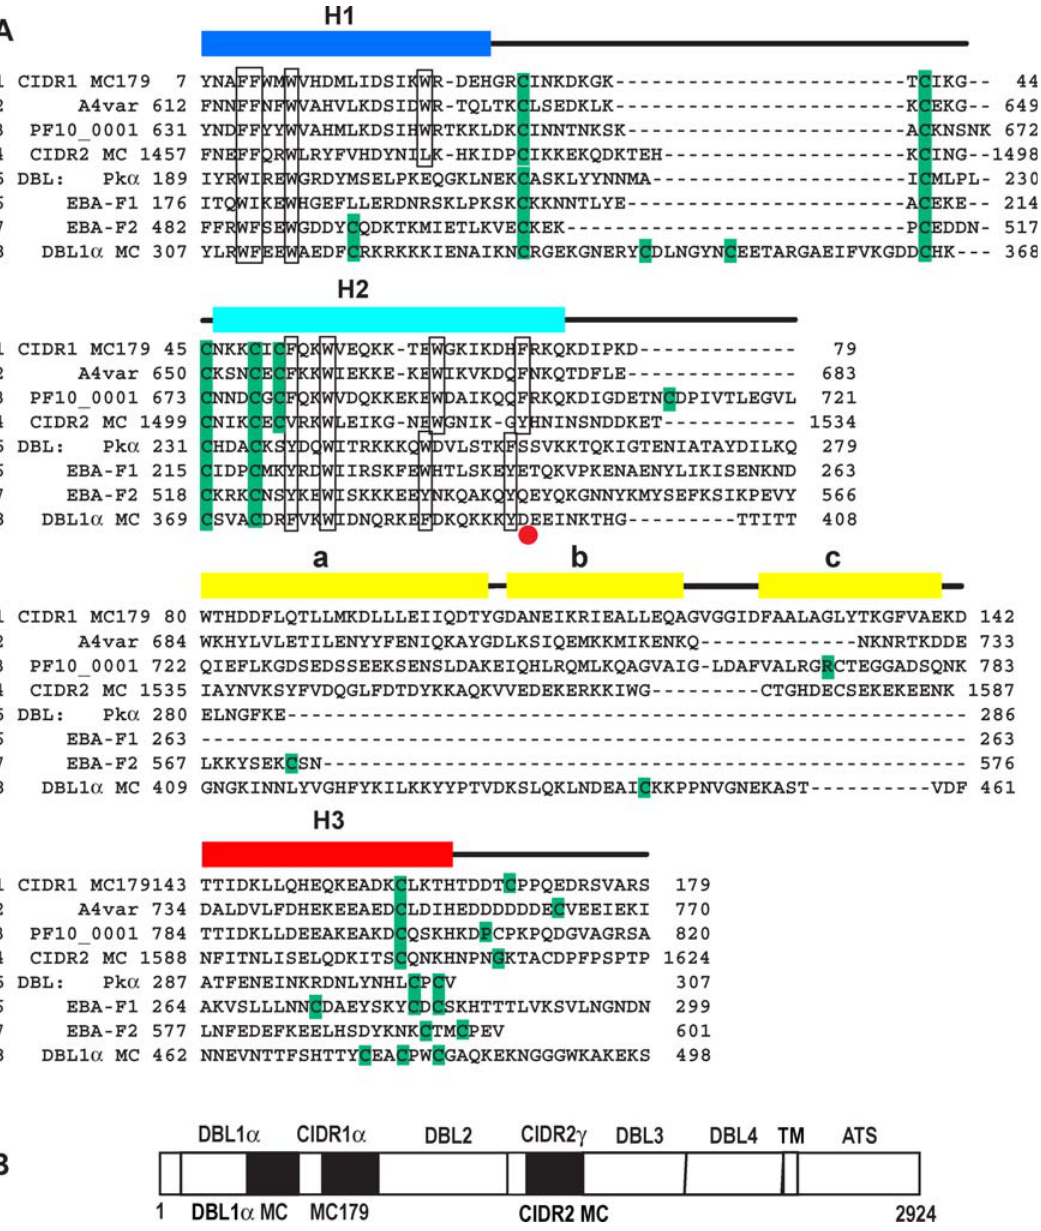
Figure 7. Sequence comparison of MC179, CIDR, and DBL domains. (A) Alignment of four CIDR and four DBL domains with the lines numbered 1–8 for clarity of discussion. Lines 1–4 show MC179 and the MC179-like portions of three other CIDR domains: line 1, CIDR1 a MC179; line 2, CIDR1 a of A4var PfEMP1; line 3, CIDR1 a of PF10_0001 of 3D7; and line 4, CIDR2 c of the MC strain (see [B]). Lines 5–8 show four DBL domains: line 5, Pk a ; line 6, EBA-F1; line 7, EBA-F2; and line 8, DBL1 a of MC PfEMP1. The sequence alignment is based on conserved cysteines (green), conserved hydrophobic residues (boxed), and on superimposed X-ray structures. Note the differing lengths and high sequence diversity in regions of lines 2–8 that are aligned with the a , b , and c helices (yellow) that connect H2 and H3 of MC179. The short connection between the H2 and H3 helices in the non-PfEMP1 DBL domains (lines 5–7) contrasts with the much longer connection observed in the MC179 structure (line 1), predicted in other CIDR domains (lines 2–4), and predicted in DBL1 a (line 8). Note the long loop in DBL1 a that connects the H1 and H2 helices. The end of the H2 helix is marked (red dot). Helices from the MC179 structure are positioned over the MC179 sequence in line 1. MC179 is numbered 1–179 based on the PDB accession code 3C64, which is the same sequence as residues 576–754 of GenBank U27338. The other sequences are numbered as in their GenBank or PDB depositions with accession codes: A4var, L42244; PF10_0001; CIDR2 MC, U27338; Pk a , 2C6L; EBA-F1, 1ZRO; EBA-F2, 1ZRO; DBL1 a MC, U27338. (B) Diagram of the entire PfEMP1 from the MC strain showing the alternating DBL and CIDR domains as in Figure 1. Filled boxes denote locations of the ‘‘DBL1 a MC,’’ ‘‘CIDR1 MC179,’’ and ‘‘CIDR2 MC’’ sequences that are aligned in (A). doi:10.1371/journal.ppat.1000147.g007 PF10_0001 (Figure 7), PFD0630c, PFD0005w from the 3D7 strain about ten residues before the start of the H3 helix. In the MC179 structure, these two C a atom positions are separated by about 8 A ˚ , have such cysteines. We predict that these cysteines form a disulfide which could be spanned by a disulfide bond. For example, bond that could act to stabilize the MC179 structure, by linking the a